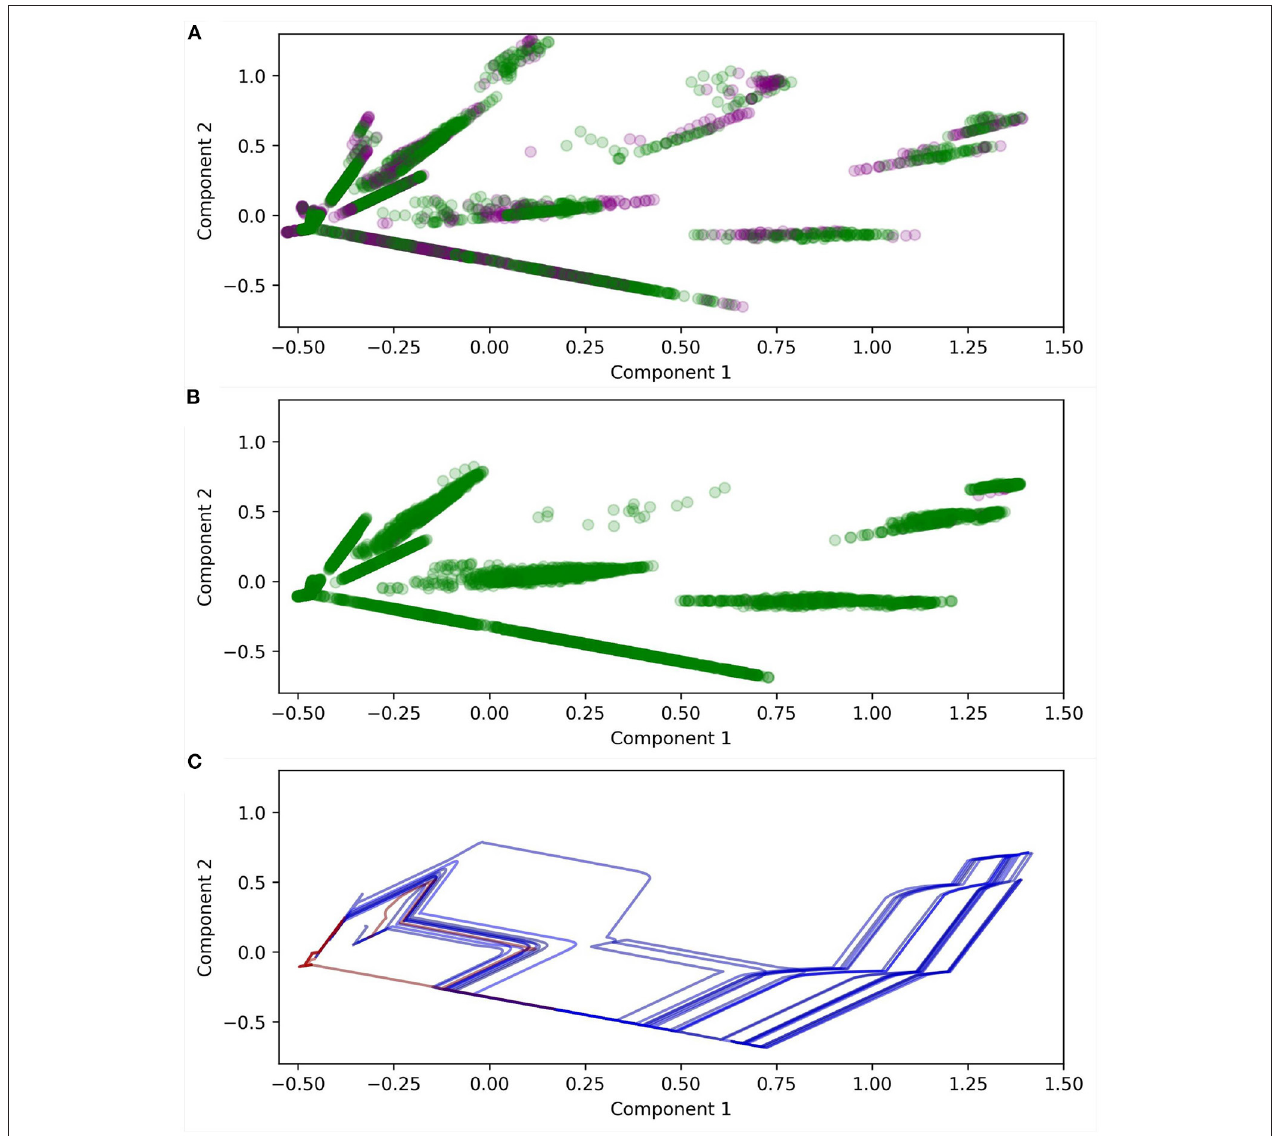
FIGURE 13 | Projections of ASM 1 derived using principle component analysis. (A) Illustrates the positions of the nodes after 100 descents of the object. Purple markers indicate inhibited nodes, green indicates reinforced nodes. (B) Illustrates the positions of nodes after 2,000 descents. (C) Illustrates the sensorimotor trajectories of the interactions with the last 10 descents of each shape. Blue indicates circles and red indicates diamonds. Note that the motor dimension is ignored because it confounds the interpretability of the plot. The rapid jumps in the plots are due to individual sensors suddenly becoming active or inactive as they intersect with the